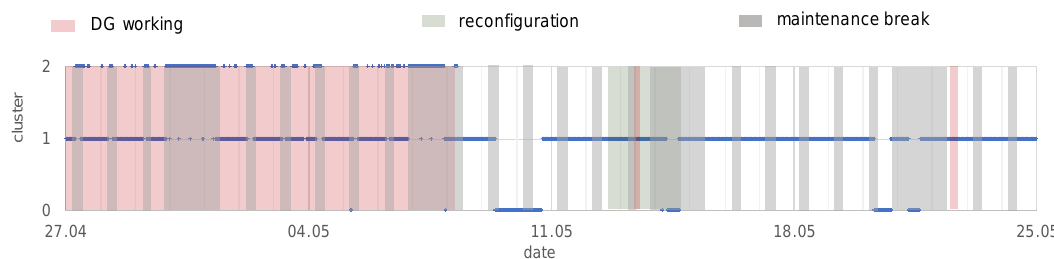
connection distance Figure 4. Dendrogram of the CA using the Ward algorithm.